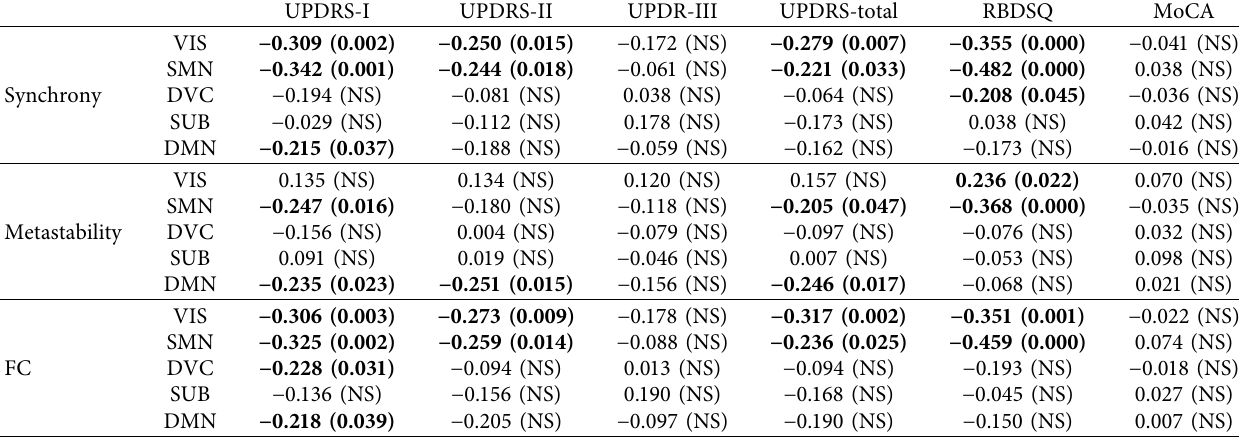
Table 2: Correlations between neuroimaging measures within RSN and clinical